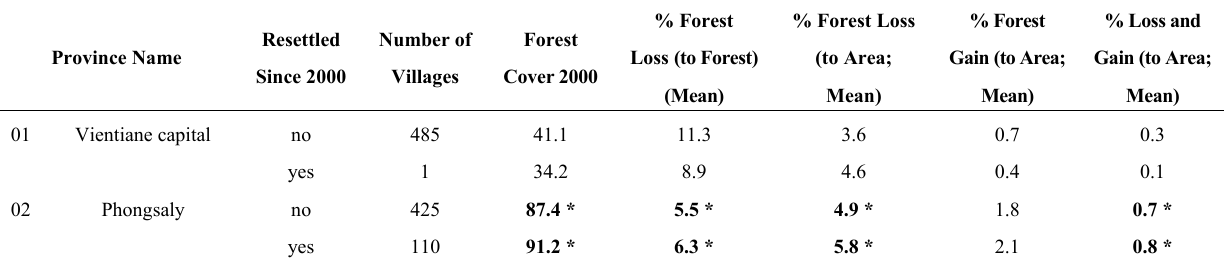
Table 5. Forest cover change statistics for resettled and non-resettled villages by